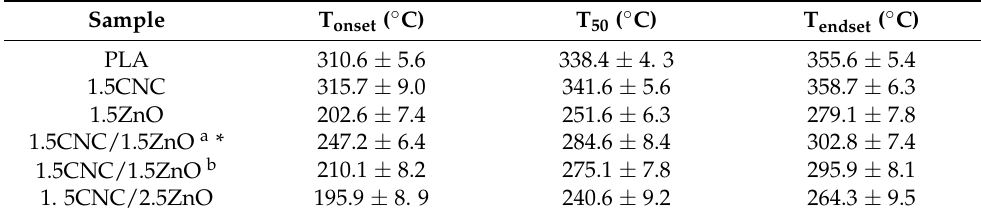
Table 3. Thermal properties of each formulation from TGA.